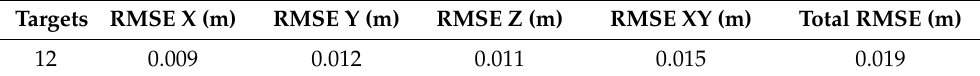
Table 4. SfM co-registering errors.